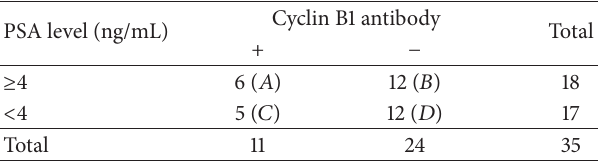
Table 2: Sensitivity of combined use of both PSA and cyclin B1 antibody in early prostate cancer detection.